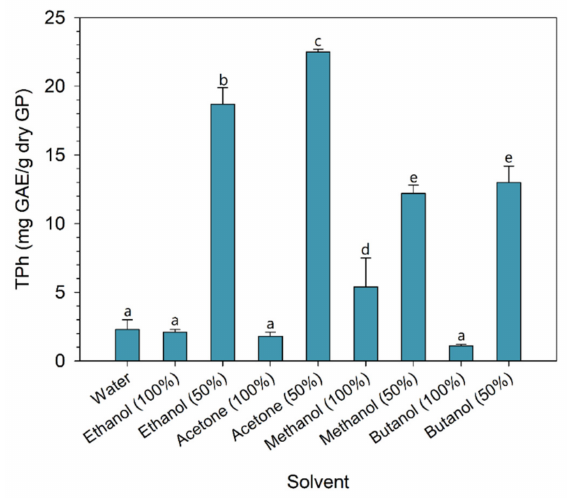
Figure 1. Total phenolic content (mean ± standard deviation) extracted for different solvents (statisti- cally significant differences are marked with different lowercase letters, at the p value <